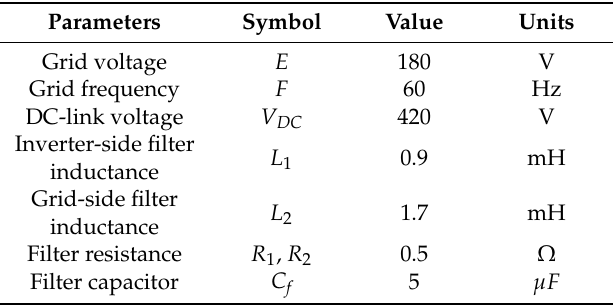
Table 1. System parameters of a grid-connected inverter.